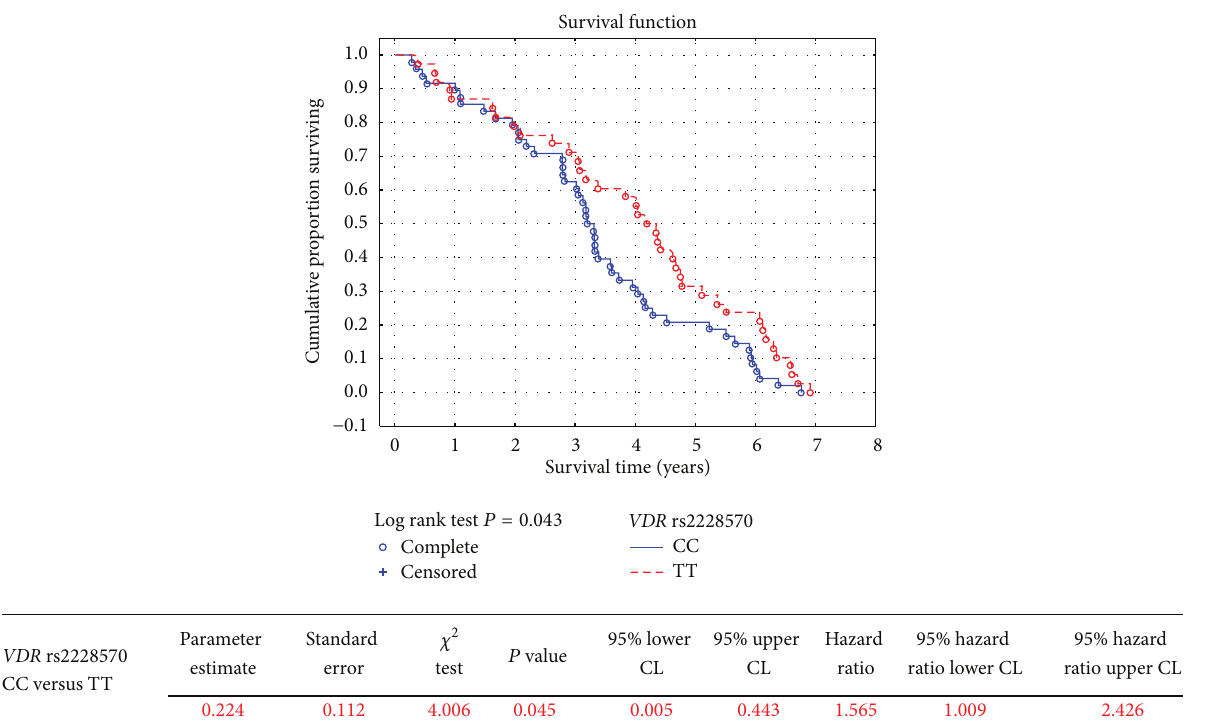
Figure 3: Cardiovascular mortality in hemodialysis patients in respect to VDR rs2228570 polymorphic